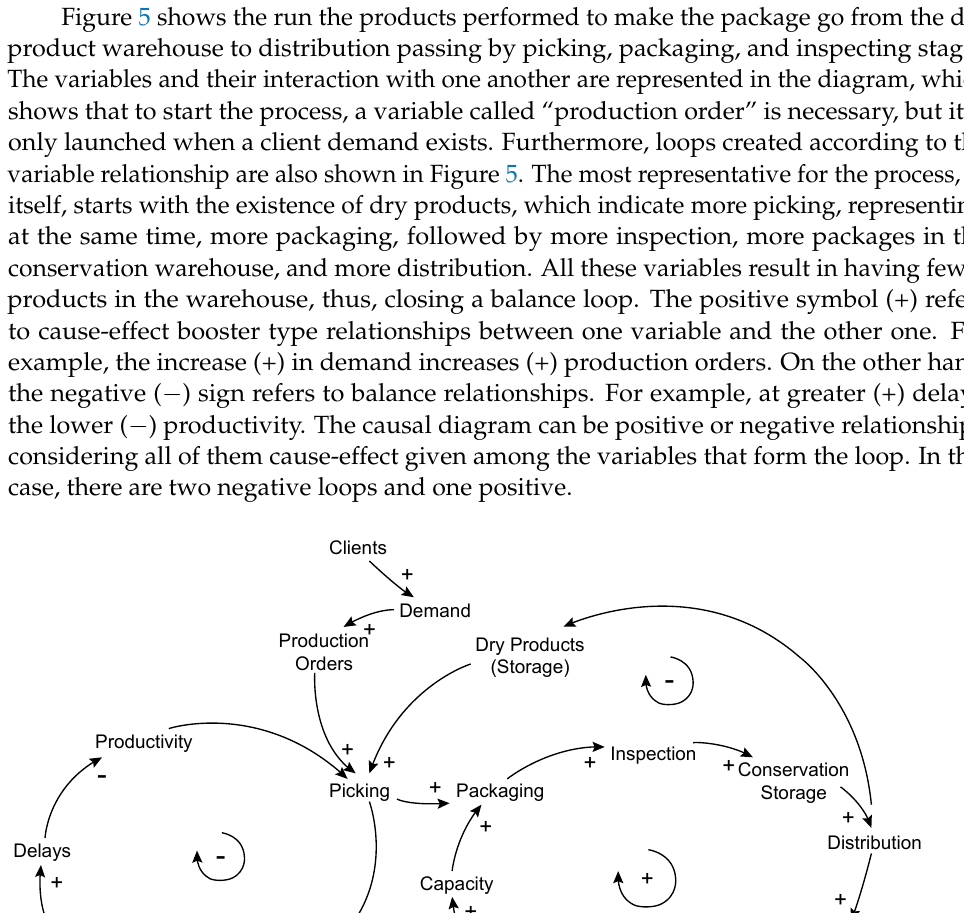
Figure 5. Causal diagram for the production process.